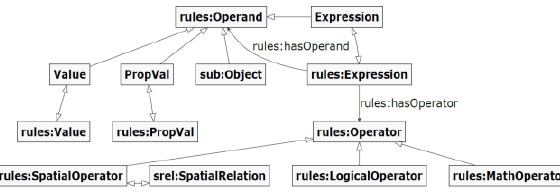
Figure 2b. Detailed view of the rule expression